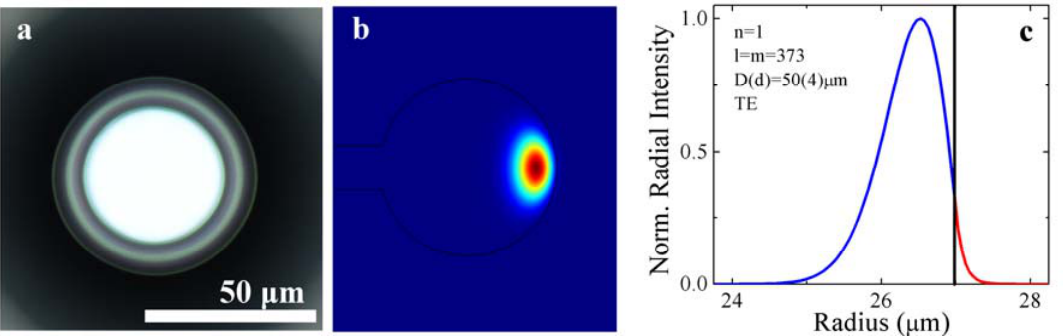
Figure 1. Optical resonant cavity. (a) An image of a microtoroid resonant cavity. (b) Finite element method simulation of the intensity of the optical field at 633 nm for a microtoroid cavity. As can be seen, the optical field is primarily confined inside the silica cavity, but a small portion evanesces into the environment. (c) The intensity profile of the optical field inside (blue) and outside (red) of the cavity. The black line indicates the air/silica